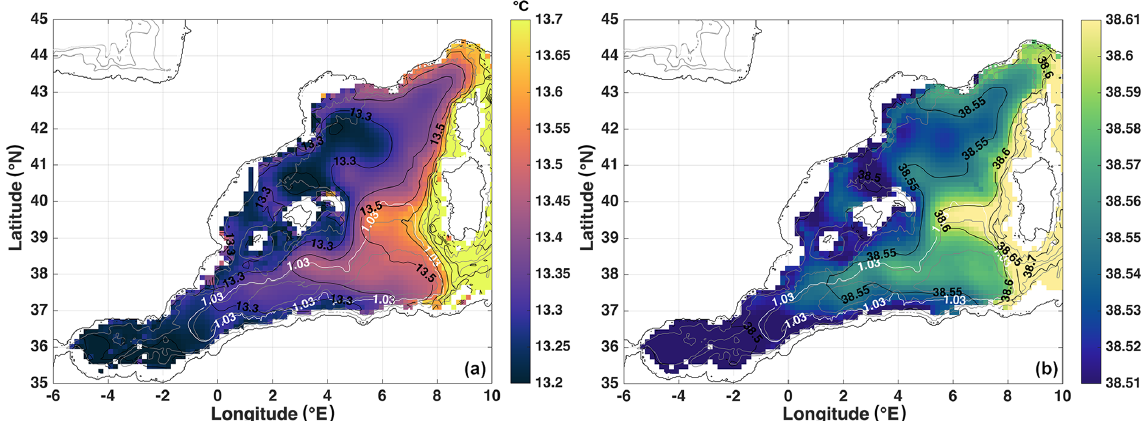
Figure 6. Climatologies of LIW potential temperature in ◦ C (a) and salinity (b) obtained from an optimal interpolation of all the available data from 1960 to 2017, on a 15km × 15km grid. The white contour denotes the normalized f/H contour 1.03, which roughly encircles the Algerian Gyres.